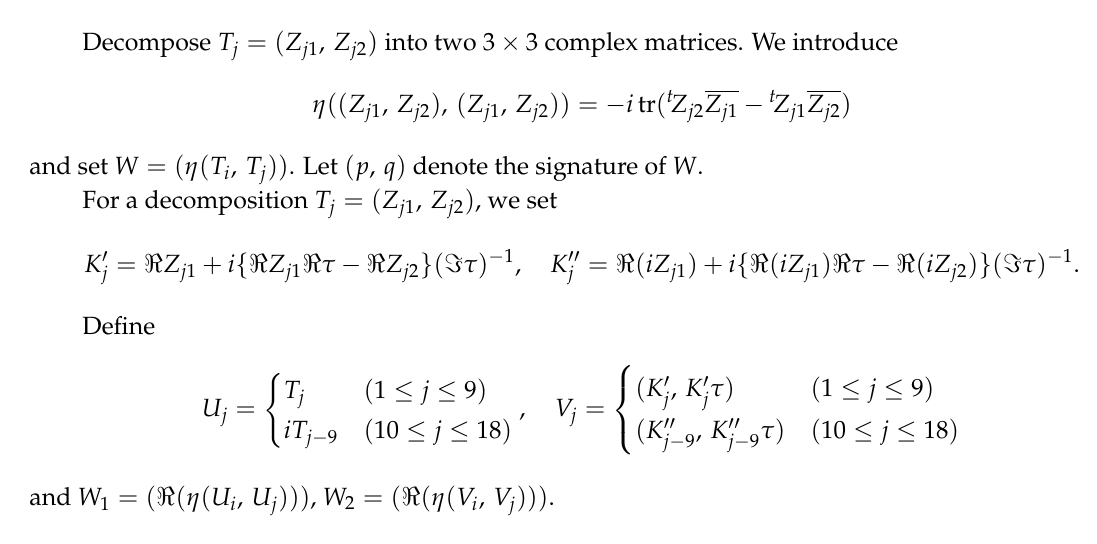
Figure 7. The graph of x 3 = det W (the red domain) and the plane x 3 = 0 (the green domain) in They intersect at a curve which looks like a straight line and curves which look like parabolic